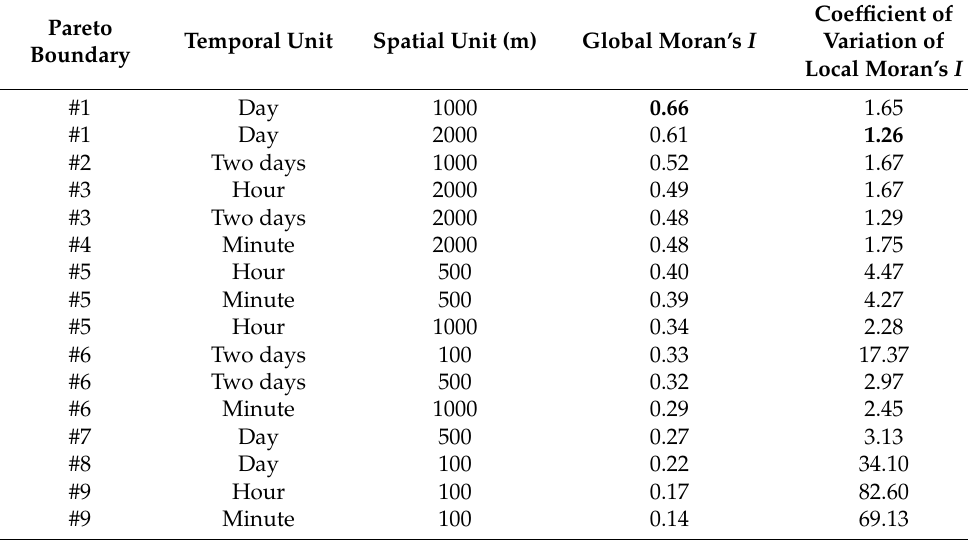
Table 3. Global and local spatial correlations and corresponding Pareto boundaries for each spa- tiotemporal analysis unit.